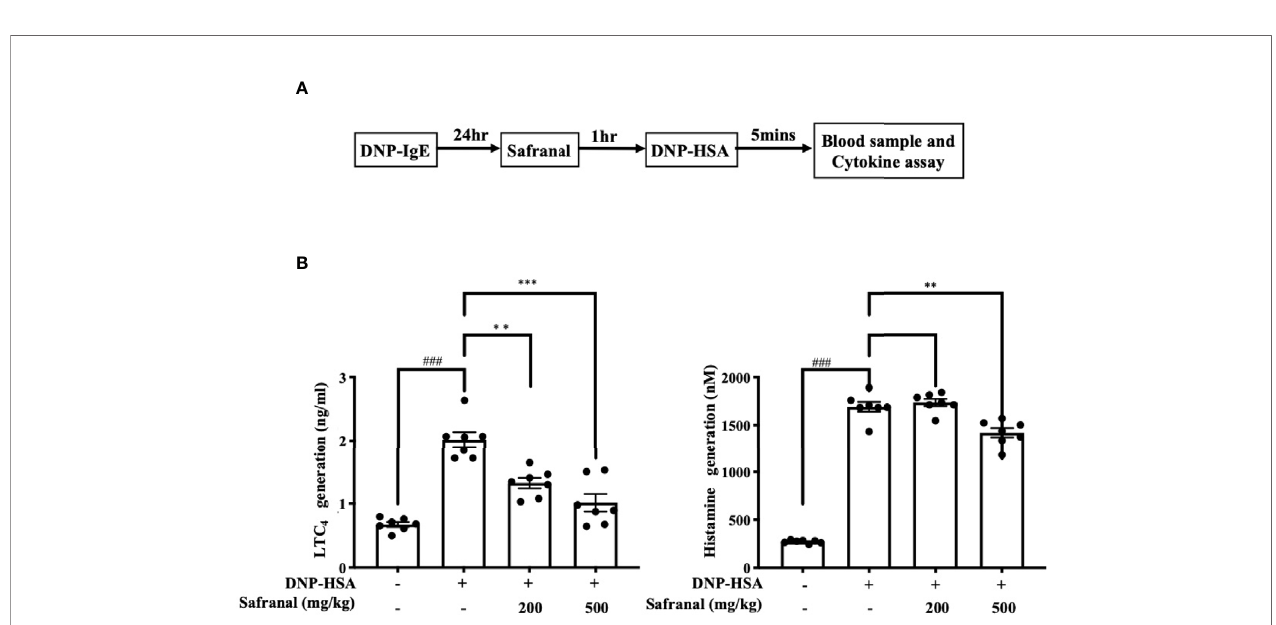
FIGURE 9 | Safranal alleviated PSA reaction. (A) Mice were sensitized with DNP-IgE 24 h before oral administration of PBS or safranal. After 1 h mice were i.v. injected with DNP-HSA for 5 min. Blood samples were collected by cardiac puncture. (B) Serum was collected and analyzed for LTC 4 and histamine production. All data shown are the means ± S.E.M. of n=7. ### p <0.001 compared to nontreated group, ** p <0.01, *** p <0.001 compared to DNP-HSA treated